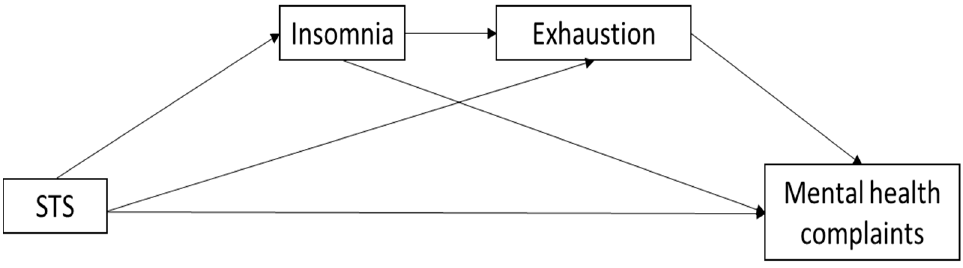
Figure 1. Hypothetical model.